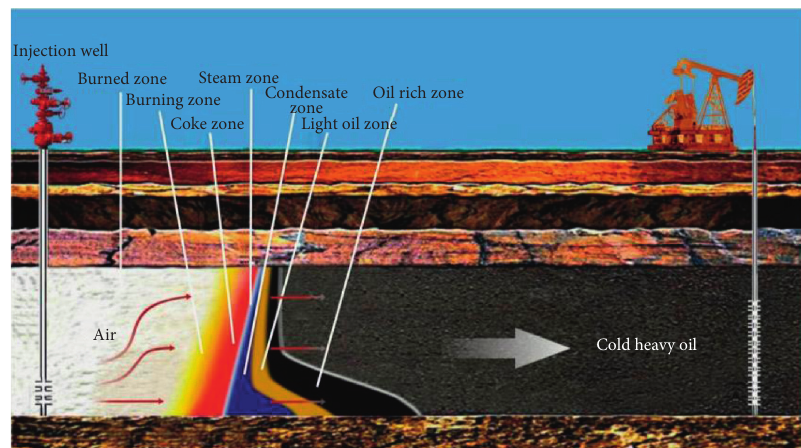
Figure 4: Schematic diagram of in situ